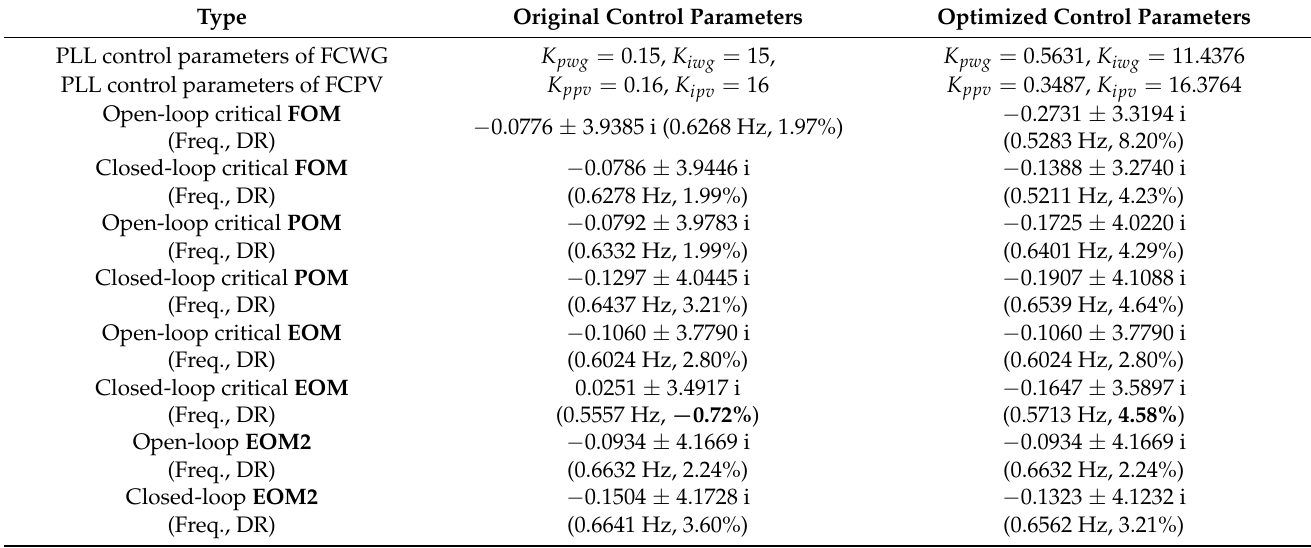
Figure 12. Active power output of 15th SG in four Cases. ( a ) Case 1; ( b ) Case 2; ( c ) Case 3; ( d ) Case 4. Table 5. Parameter optimization of FCWG and